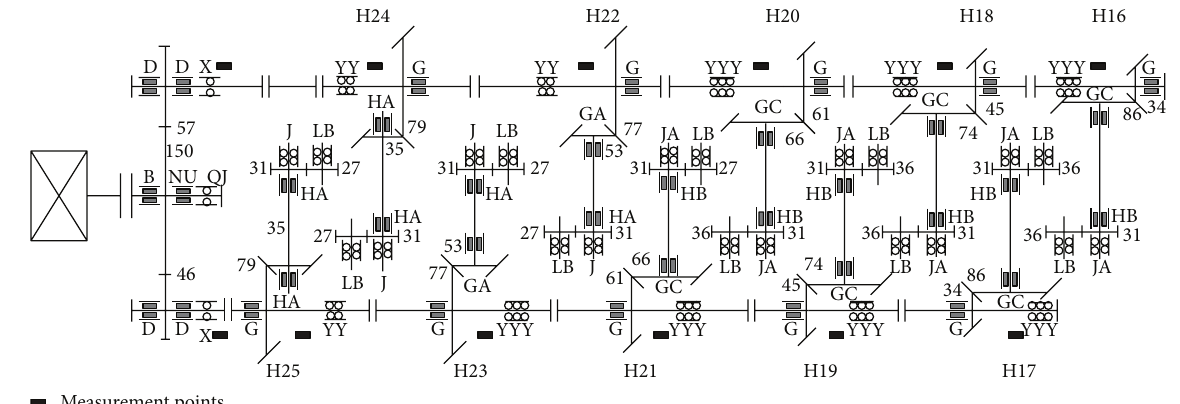
Figure 7: Driving chain of